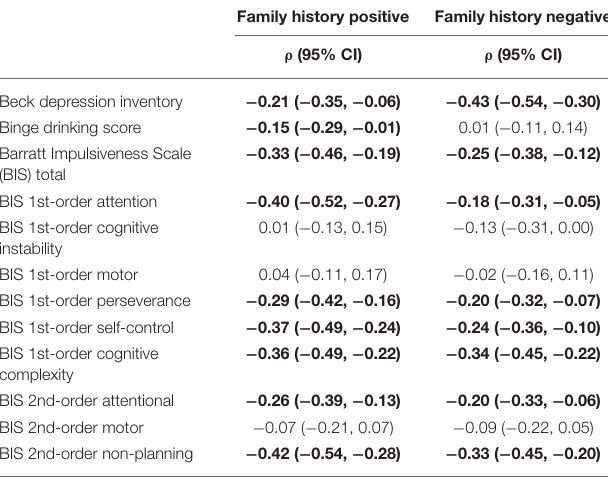
TABLE 2 | Correlations between Connor-Davidson Resilience Scale (CD-RISC) scores and clinical measures in individuals with or without a family history of alcohol use